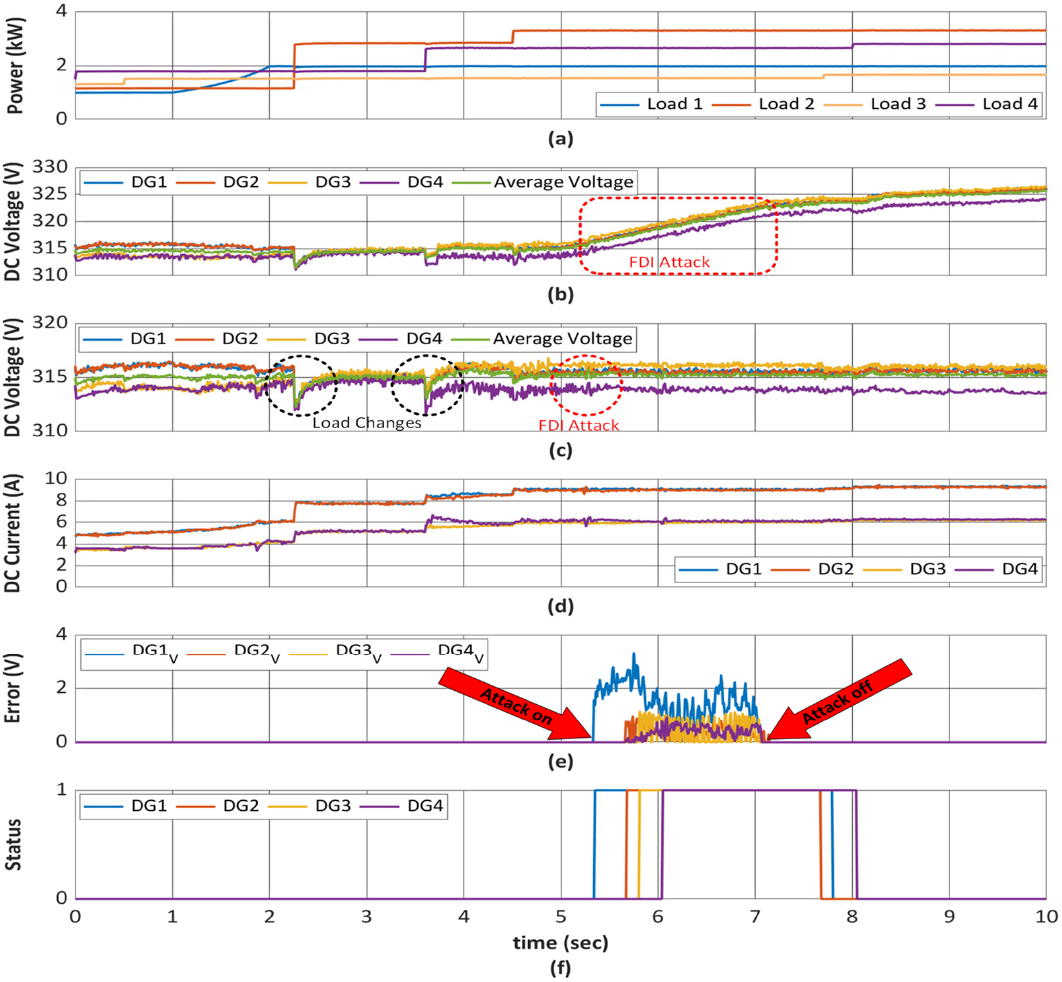
Figure 4. System performance in the presence of voltage sensor FDIAs: ( a ) Load profiles. ( b ) Output DC voltages of a standard secondary controller. ( c ) Output DC voltages with proposed method ( d ) Output current with proposed method. ( e ) Error signals. ( f ) Final status of DGs in attack presence.